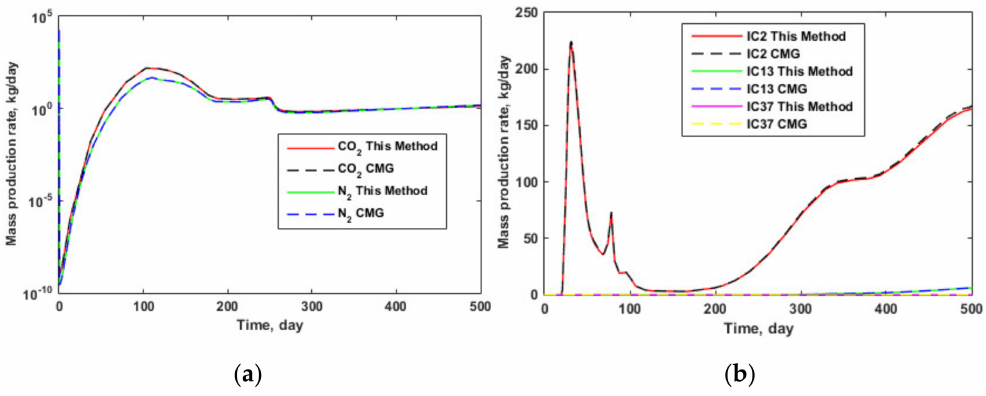
Figure 9. Production curves of this reservoir model. ( a ) Inorganic component; ( b ) organic